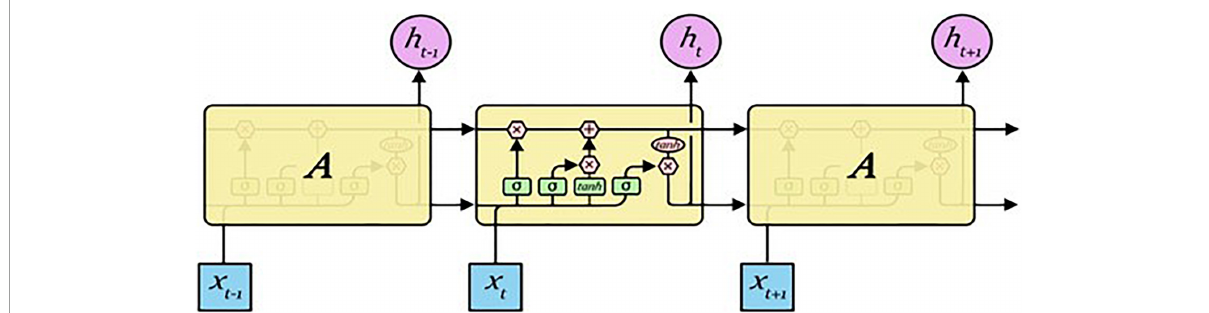
FIGURE4 LSTM structure.